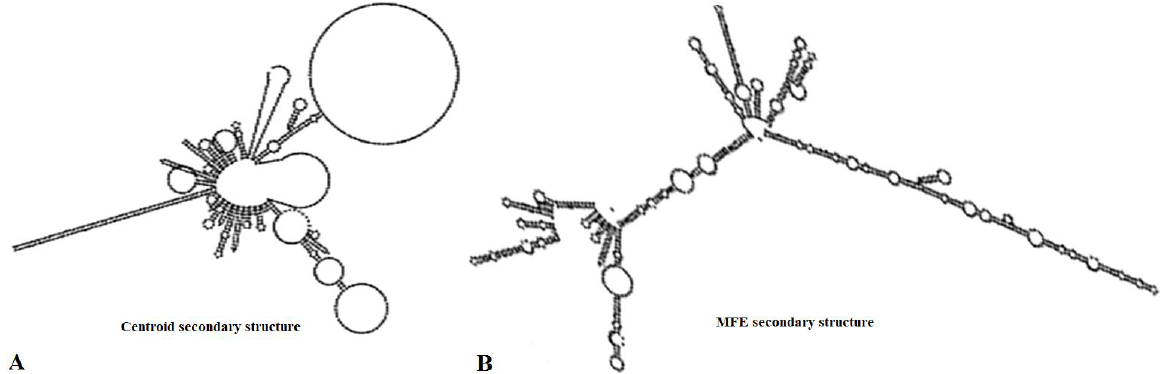
Fig. 1. Prediction of the secondary structure of mRNA of fused protein: A) Secondary structure of mRNA of LTP and Osmotin genes; B) minimal free energy (MFE) of mRNA secondary structure. Prediction of the secondary structure of the fused protein was obtained by PSIPRED